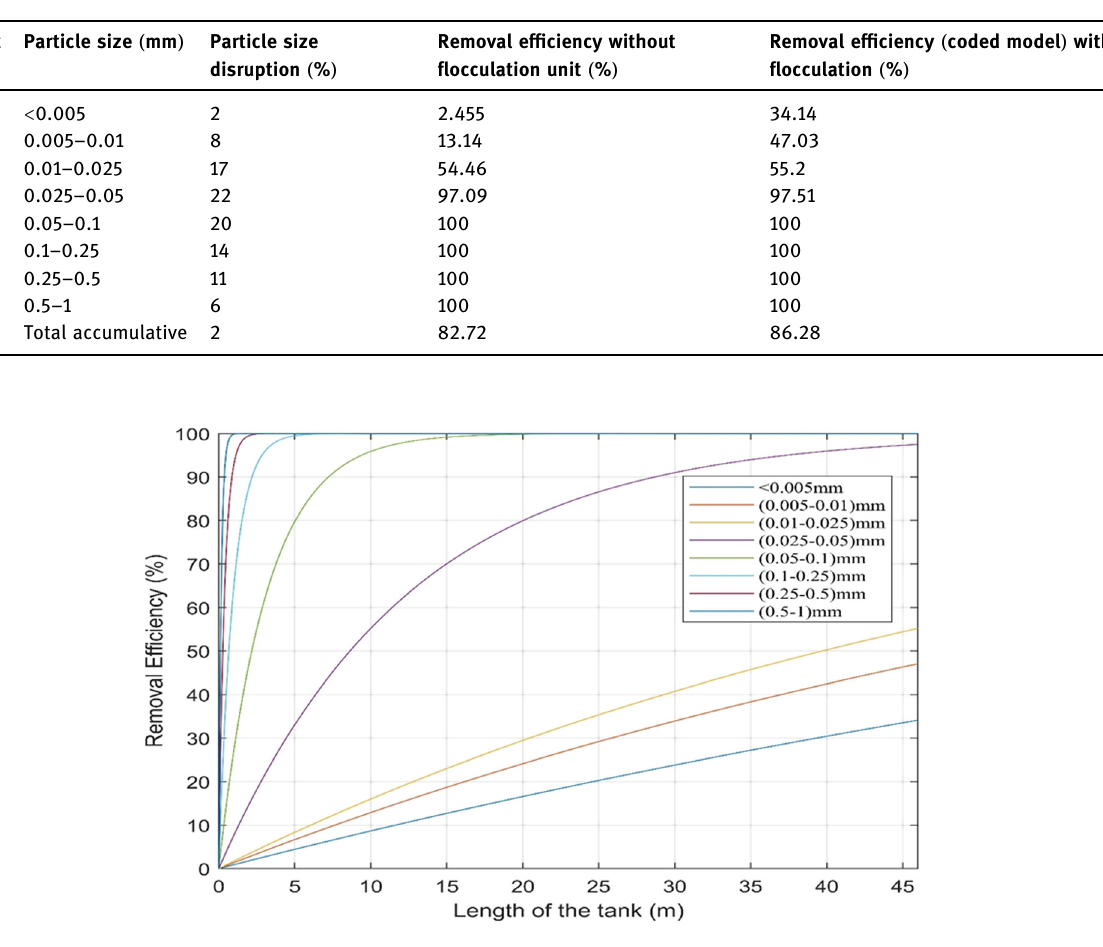
Table 3: Two scenarios of AL - Muthana WTP removal e ffi ciency